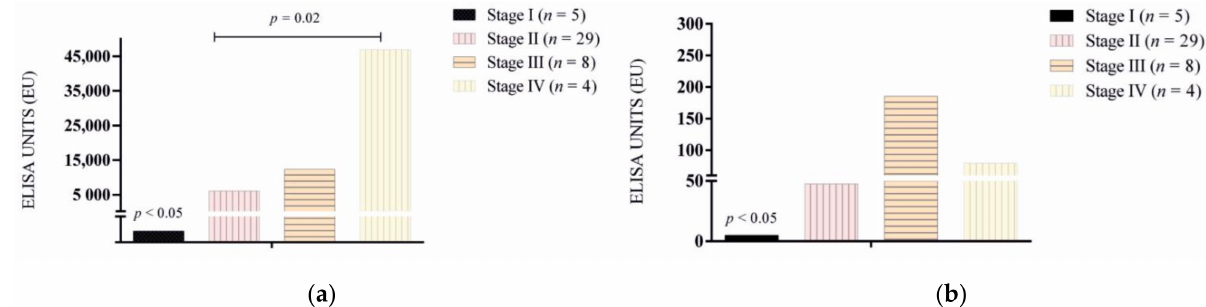
Figure 2. Specific ( a ) L. infantum and ( b ) rKMP11 antibody levels in sick dogs (Group 2) classified based on LeishVet clinical staging. Table 1. Positive results to specific L. infantum and rKMP11 antibodies in apparently healthy non- infected dogs from Asturias (Spain), a low endemicity area (Group 1), sick dogs from Catalonia (Spain) (Group 2), apparently healthy Ibizan hound dogs from the high endemicity area of Mallorca (Spain) (Group 3), and apparently healthy dogs from the high endemicity area of Bari, Italy (Group 4). Positive Antibody Response Total Dogs ( n = 108) L. infantum N (%) rKMP11 N (%) Group 1 ( n = 26) 0 (0) 0 (0) Group 2 ( n = 46)